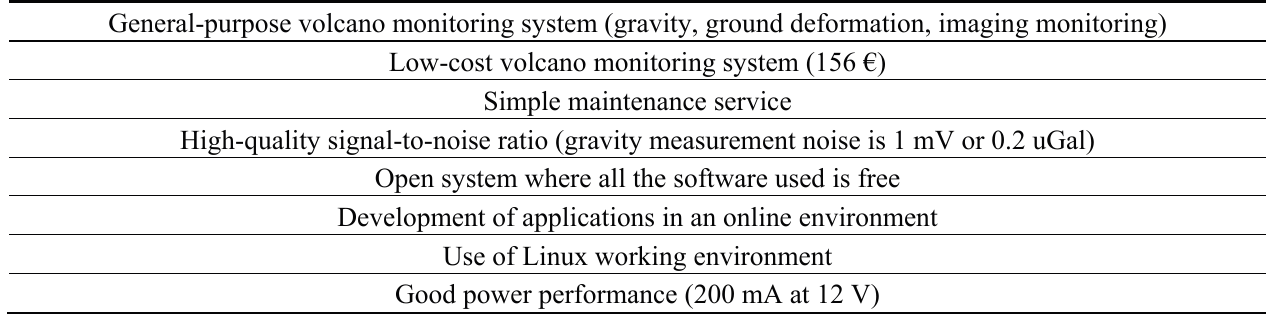
Table 17. Advantages